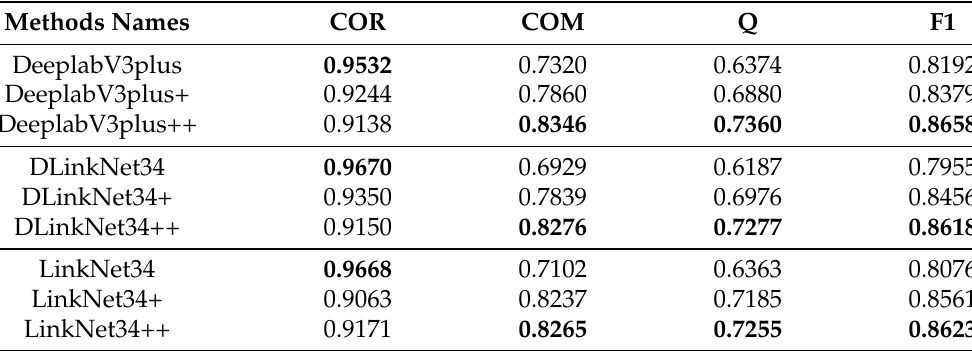
Table 3. Comparative quantitative Evaluation Among Different Methods for Road Centerline Extrac- tion on our dataset. It Should Be Noted That the Results are the Average Performance of all Images in Test Set. With the best results marked in bold.